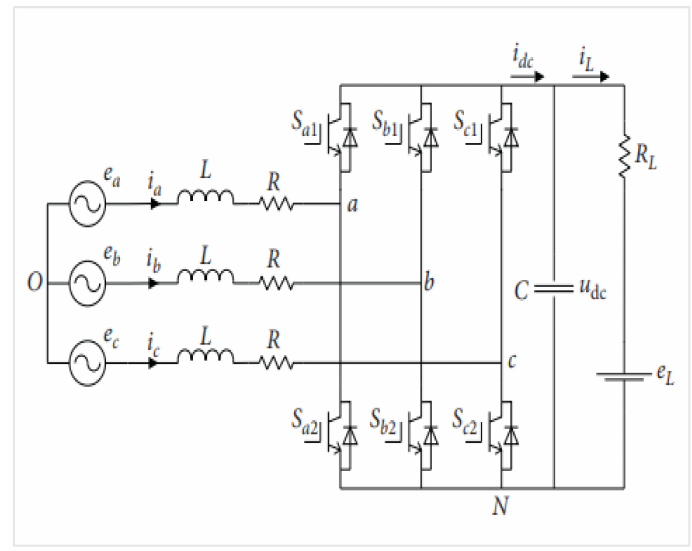
Figure 4. AC-DC bi-directional converter topology